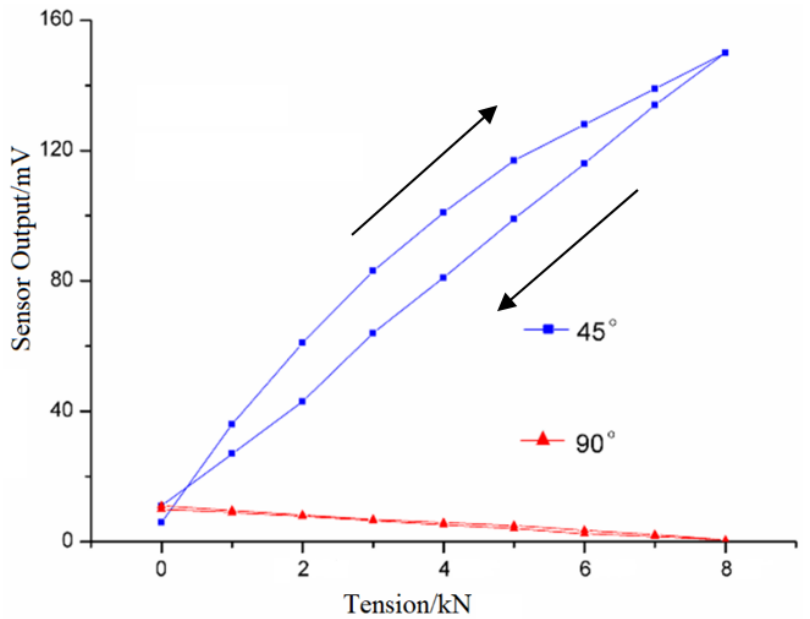
Figure 10. Sense signal curve with stress variation and the principal stress direction at different angles.